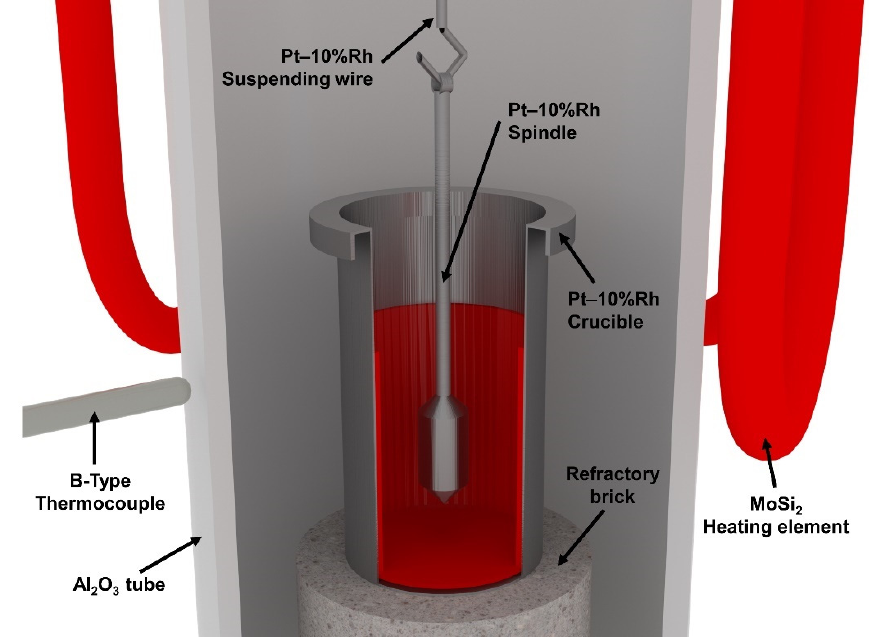
Figure 1. Schematic of the viscosity measurement apparatus.